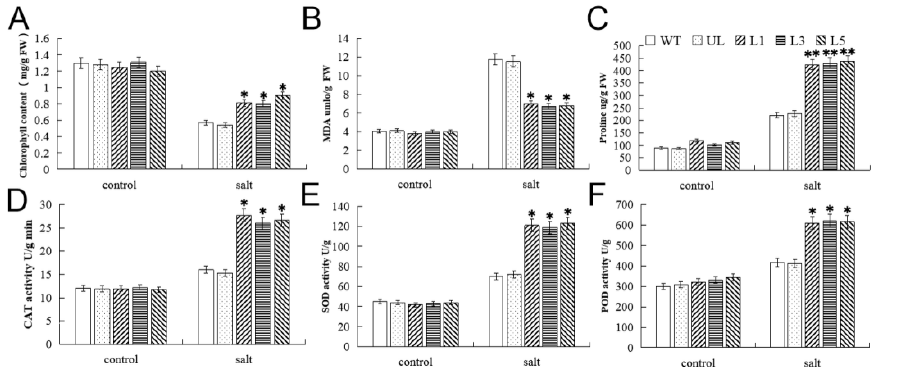
Figure 6. Physiological indicators in transgenic A. thaliana lines overexpressing FvMYB82 under salt treatment. Contents of ( A ) Chlorophyll, ( B ) MDA, ( C ) proline, and the activities of ( D ) CAT, ( E ) SOD, and ( F ) POD in the WT, UL, and FvMYB82 -OE lines (L1, L3, and L5) under 200 mM NaCl treatment for 7 days. Significant differences were marked with asterisks above the error bar (* p ≤ 0.05, ** p ≤ 0.01). The levels of indicators in the WT were used as the control. 2.5. Overexpression of FvMYB82 Improved the Expression Levels of Salt Tolerance-Related Genes